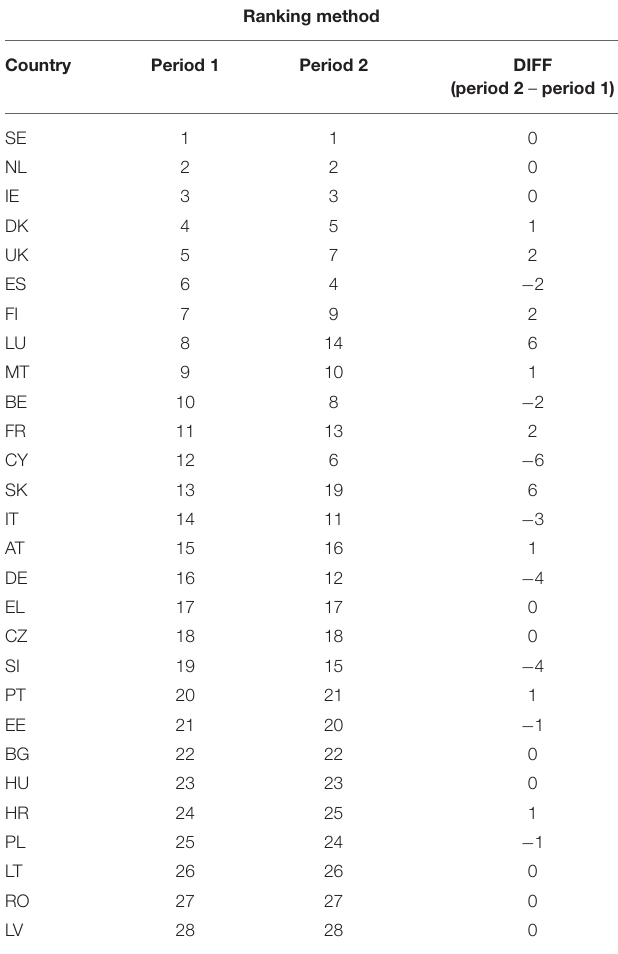
TABLE 5 | Ranks of the EU countries by ranking method. TABLE 6 | Spearman’s correlation between the used ranking